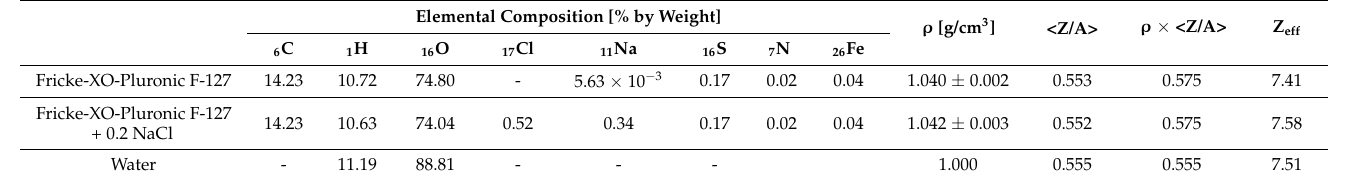
Table 3. Elemental composition and tissue equivalence of Fricke-XO-Pluronic F-127 without and with 0.2 M NaCl in reference to water.